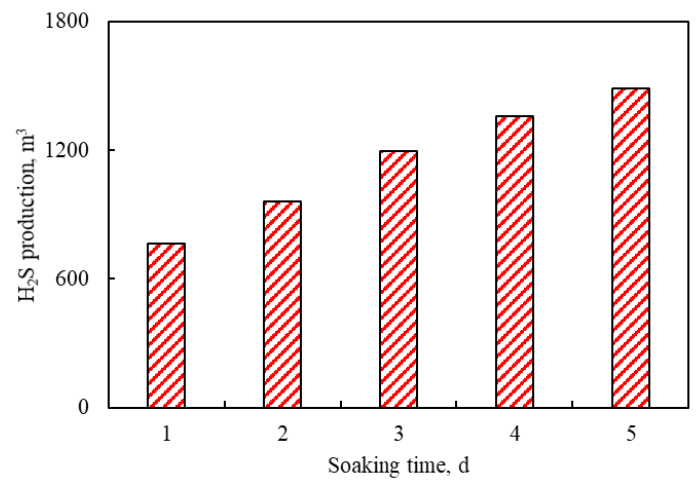
Figure 11. Effects of soaking times on H 2 S production.